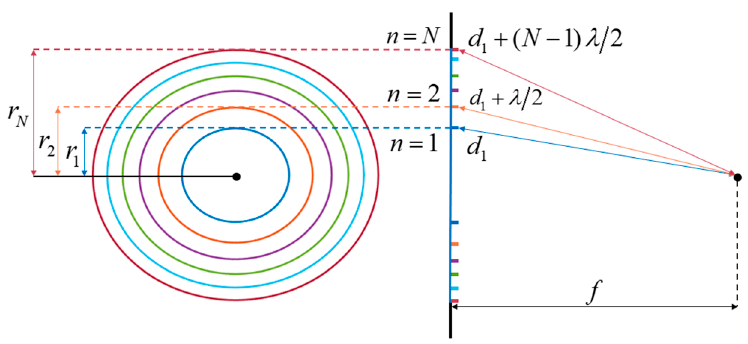
Figure 1. Diagram of the proposed Fresnel zone plate and its associated